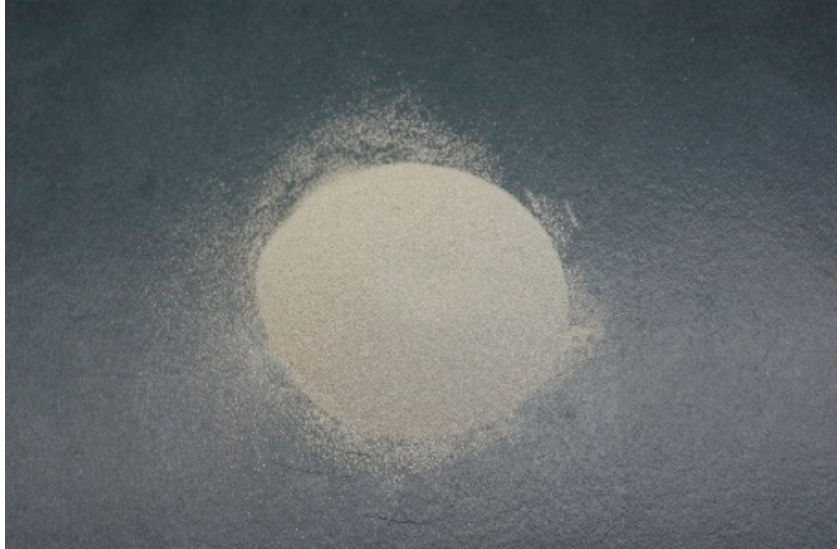
Figure 8. Magnesium powder used in the experiment.